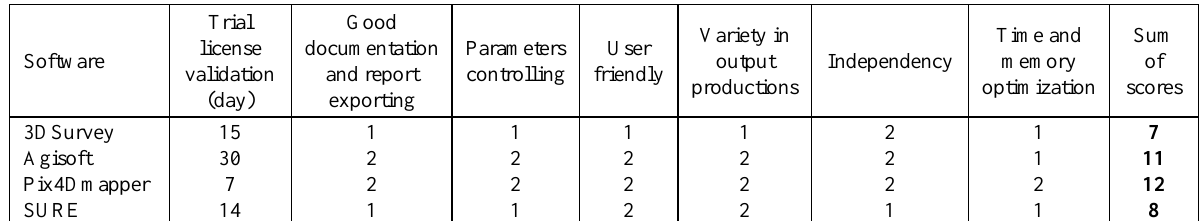
value of NMAD (0.01 m) is for the height differences between Pix4Dmapper Pro's and SURE's DSMs, while the highest value is for the height differences between 3DSurvey's DSMs (0.1 m) and other three software. It indicates that the 3D models from Pix4Dmapper Pro, SURE and Agisoft Photoscan are similar to each other and are different from the 3DSurvey result.